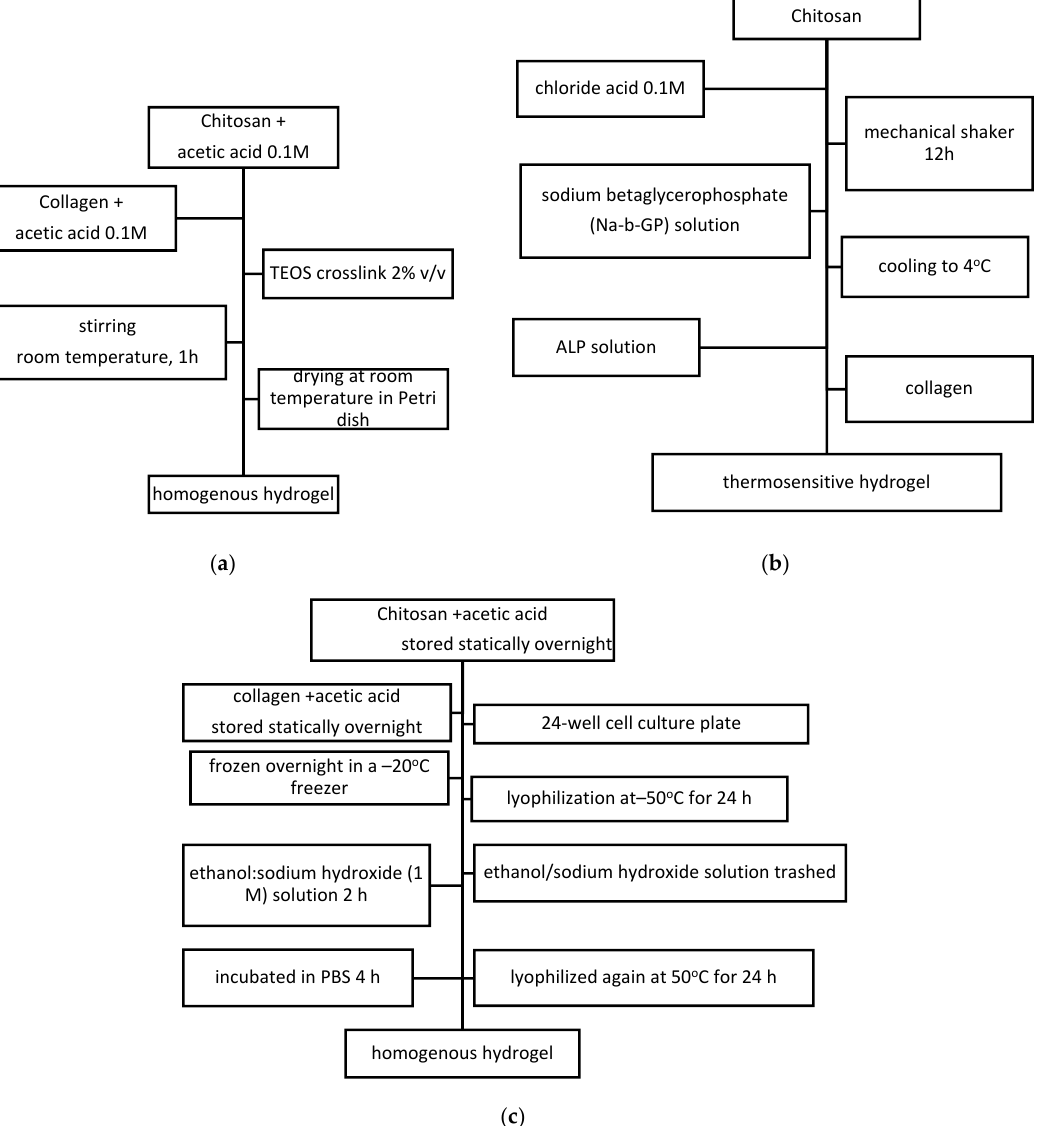
Figure 6. Synthesis route of: ( a ) Collagen–chitosan using pre-gel solution 10 mg/mL alginate and 2.5 mg/mL collagen. ( b ) Collagen–chitosan thermosensitive hydrogel. ( c ) Collagen–chitosan homogenous hydrogel for nerve tissue regeneration.